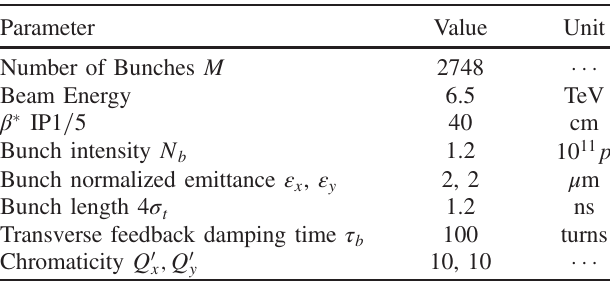
TRANSVERSE BEAM INSTABILITIES IN THE TABLE I. Bunch and machine parameters for a full machine in 2016 that was used to compute the stability diagram shown in Fig. 3.